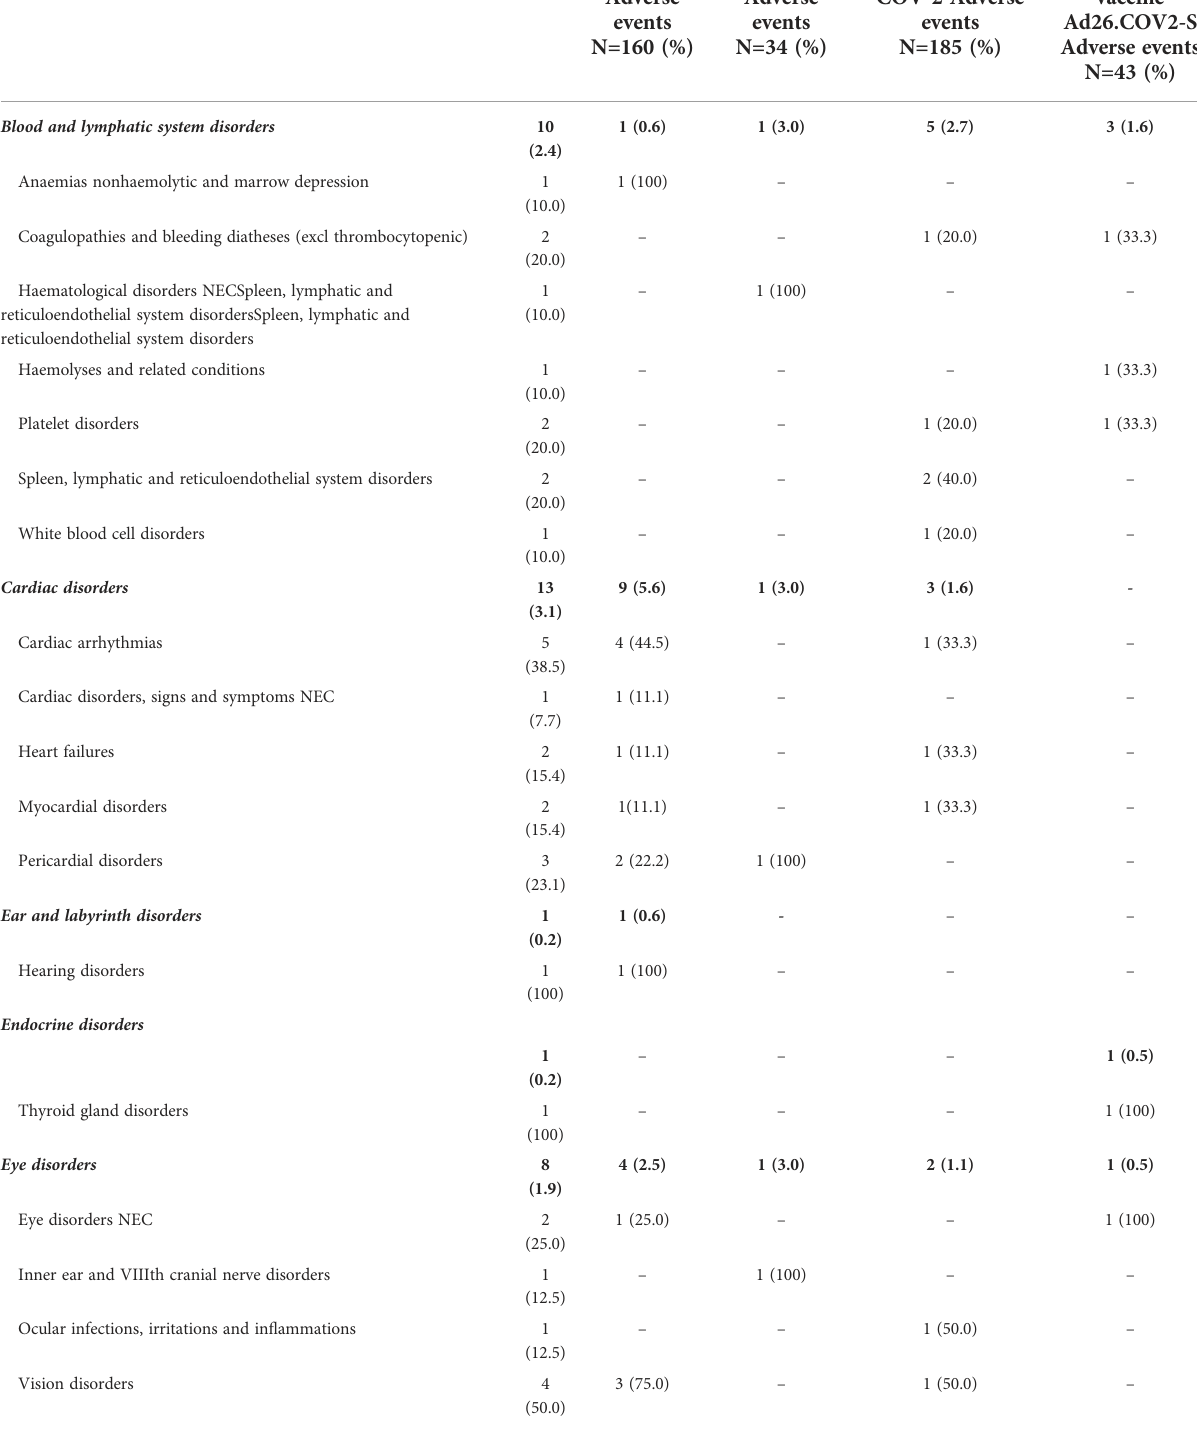
TABLE 2 Distribution of adverse events overlapping with CLS and reported in all COVID-19 Vaccines ICSRs collected in the EudraVigilance spontaneous reporting system from January 1 st , 2021 to January 14 th , 2022, categorized by MedDRA System Organ Class, and High-Level Group Terms (HLGT) within each System Organ Class